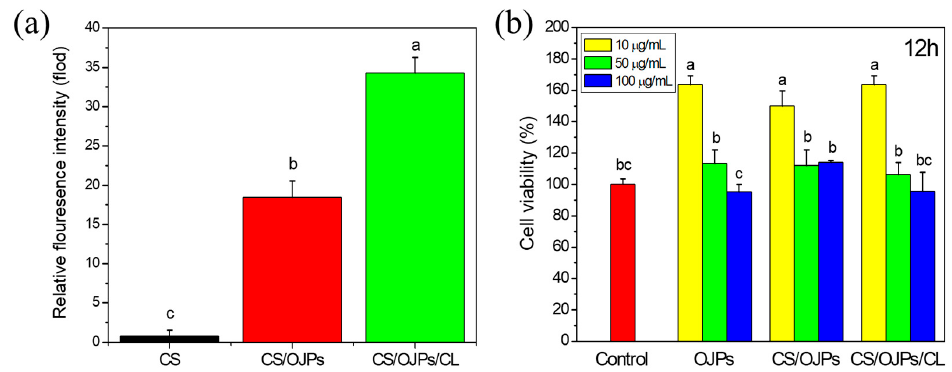
Figure 7. Phagocytic uptake and cytotoxicity: ( a ) cellular uptake CS/OJPs and CS/OJPs/CL NPs by RAW264.7 cells and ( b ) cell viability of RAW264.7 cells incubated together with CS/OJPs and CS/OJPs/CL NPs. The different lowercase letters represent statistically significant differences ( P < 0.05).